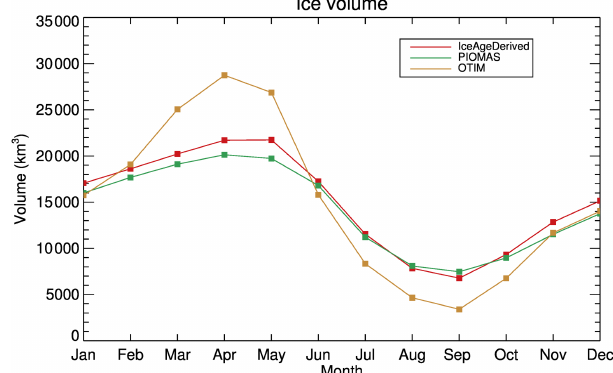
Figure 14. Mean annual cycle of ice volume for 1984–2018 over the Arctic